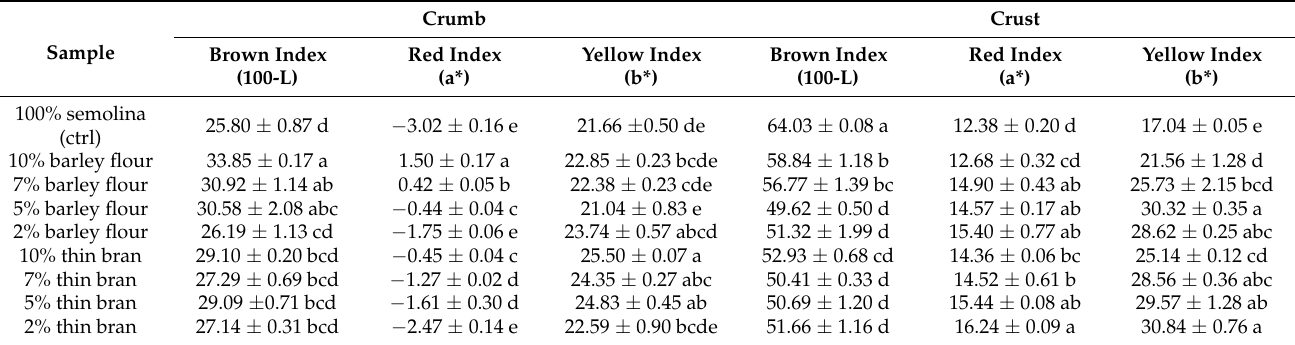
Table 13. Colorimetric parameters on different bread formulations: one-factor ANOVA (analysis of variance) (data are means ± standard deviations).